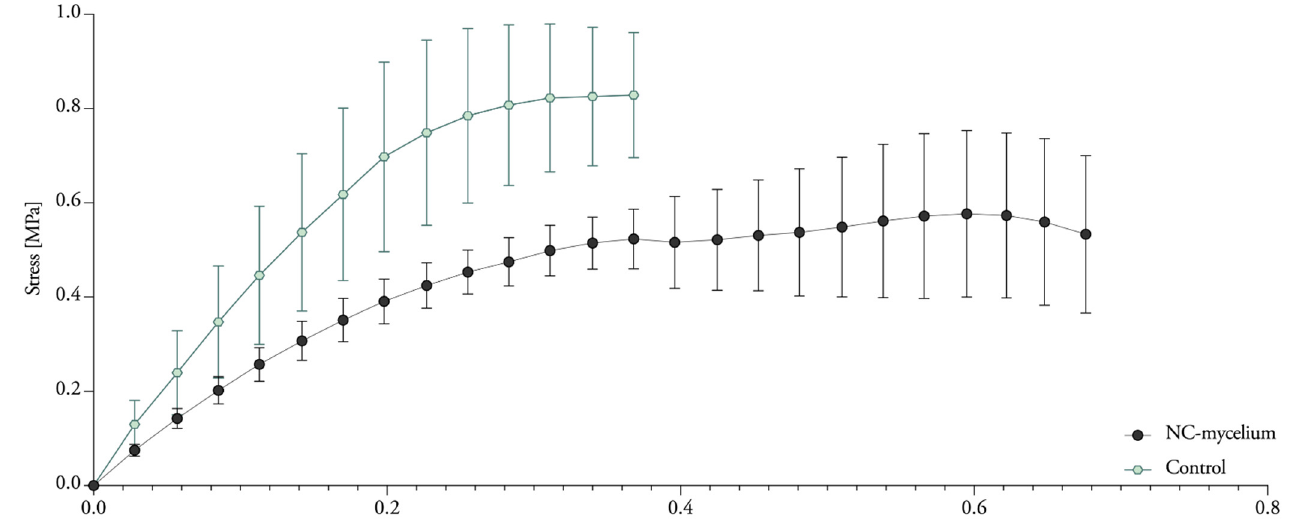
Figure 10. Stress–strain curves of tensile tests of nanoclay–mycelium composites. Table 2. Overview of the material properties in tension of nanoclay–mycelium composites. The standard deviation is performed with triplicate specimens (mean ± one standard